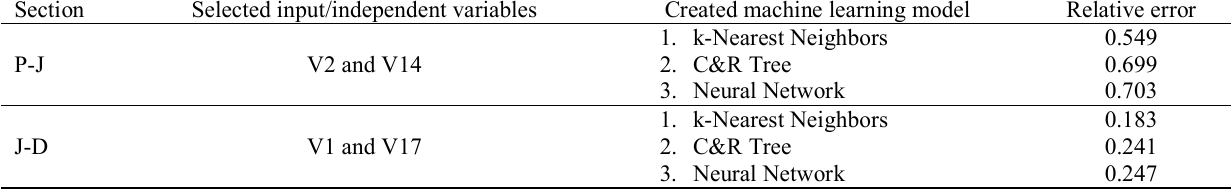
Table 5. The best machine learning models ranked by relative error for both road sections.